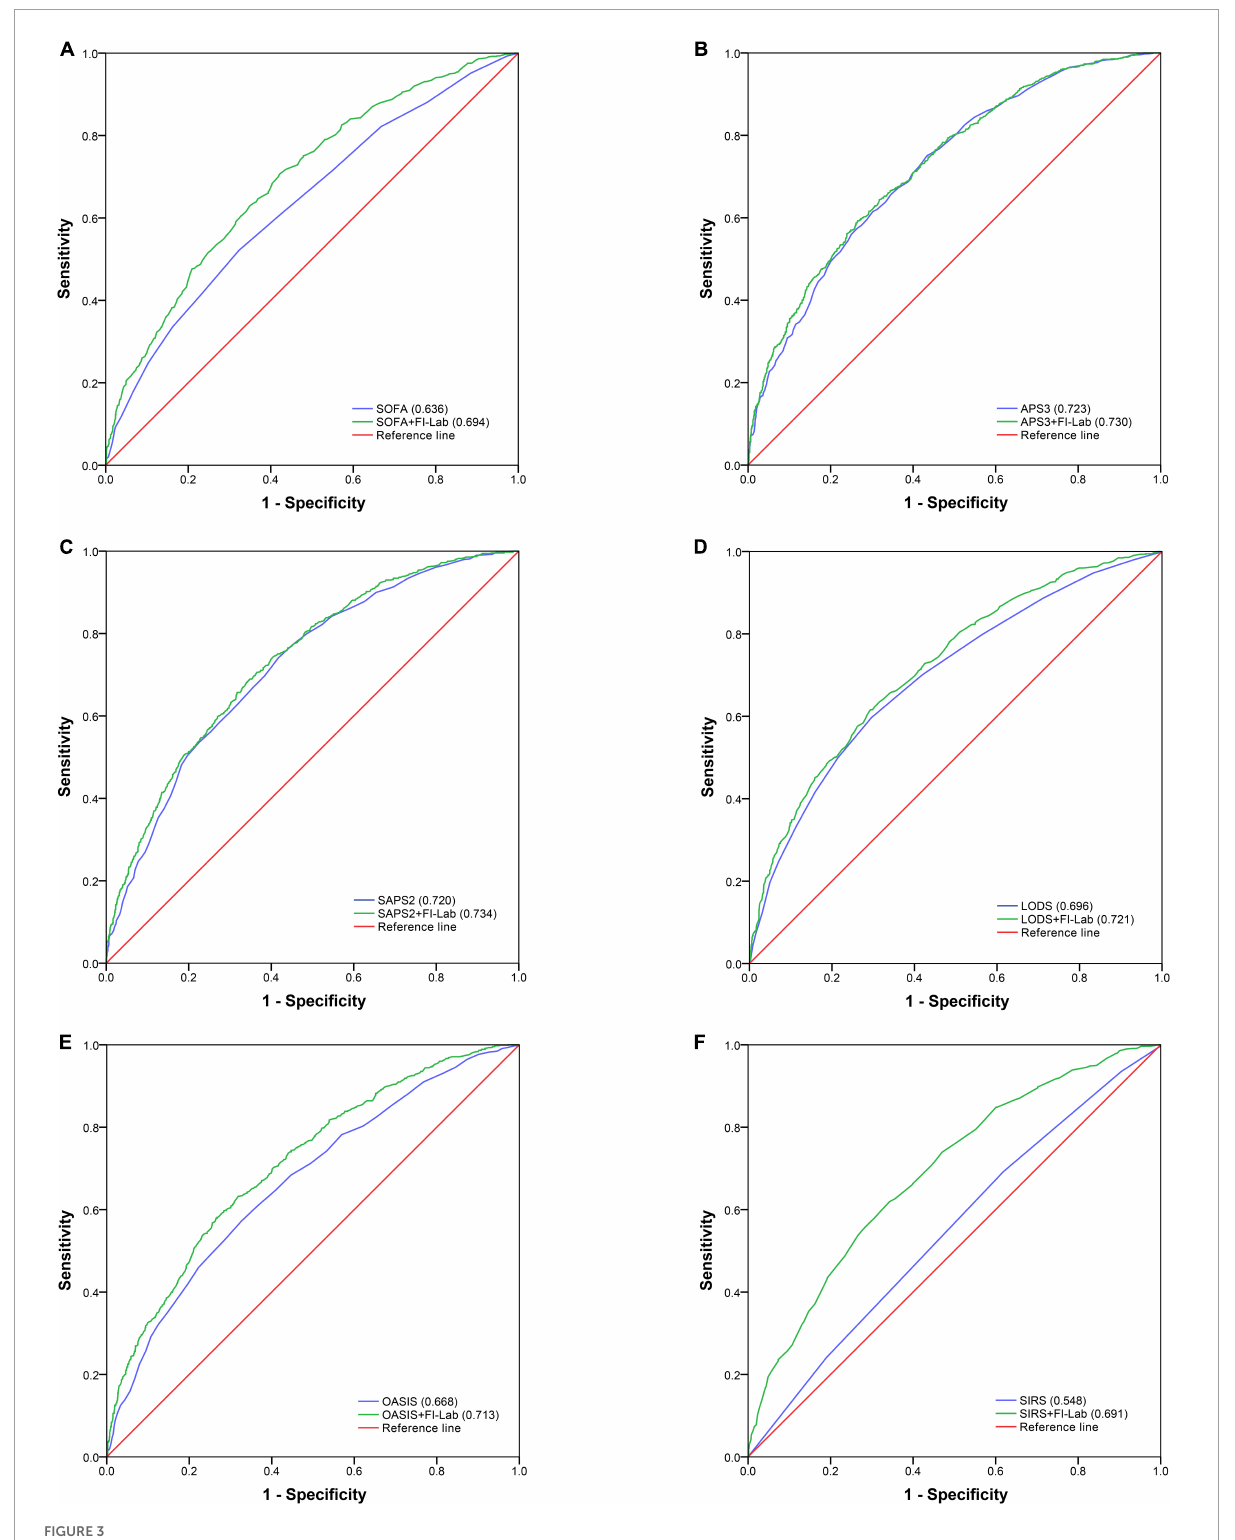
FIGURE3 Area under the receiver operator curve for 1-year